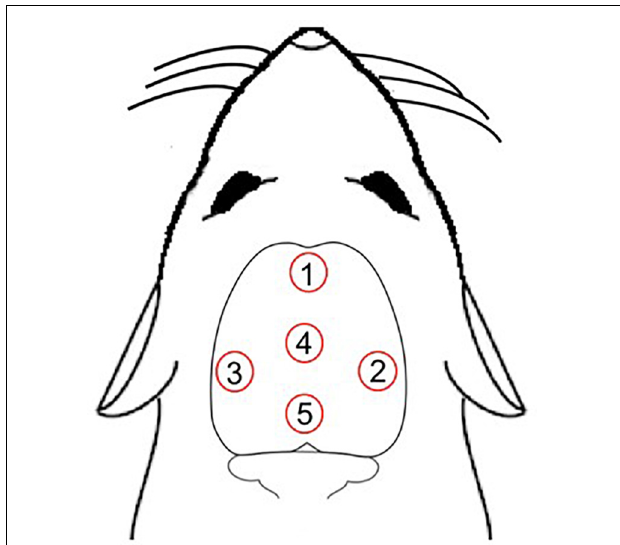
FIGURE 1 | Five irradiation points over the scalp. Point 1, targeted frontal lobe; point 2, targeted right posterior parietal and temporal lobes; point 3, targeted left posterior parietal and temporal lobes; point 4, targeted anterior parietal lobe; point 5, targeted occipital lobe (Paxinos and Watson,